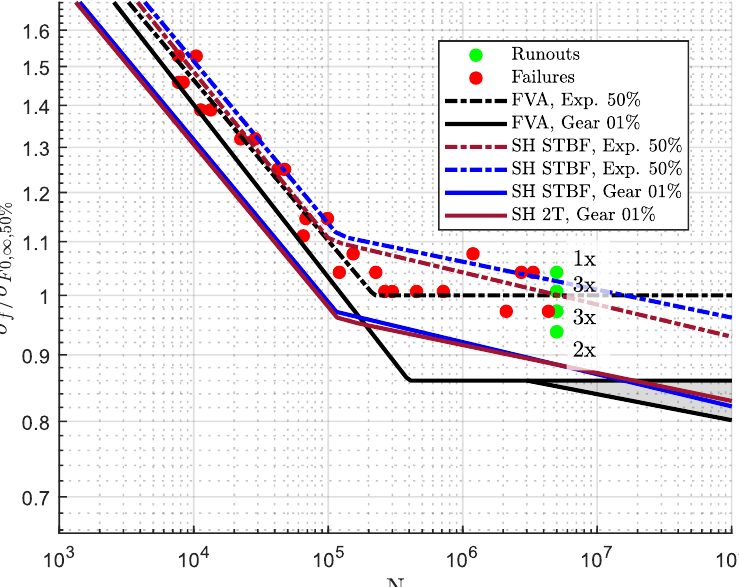
Figure 14. Comparison of the two estimation methods for exemplary campaign E from [27,28]. The first difference between the two estimation methods is the different positions of the fatigue knee. Especially for the Exp. curves, method 2 always estimates the knee above the one estimated by method 1. This different position is related to the different estimations of the complete SN curve. On the one hand, according to method 1, the fatigue knee is estimated as the intersection of the line describing the limited-life and the long-life regions. On the other hand, according to method 2, the fatigue knee location depends on the two estimated CDF parameters ( N e and σ e ) and the CDF elaboration. However, neither method 1 nor method 2 present a smooth passage between the two regions. This aspect is taken into account within more complex SN curve estimation methods (e.g., [68–73]). Their application within the case of pulsator test elaboration is the subject of current